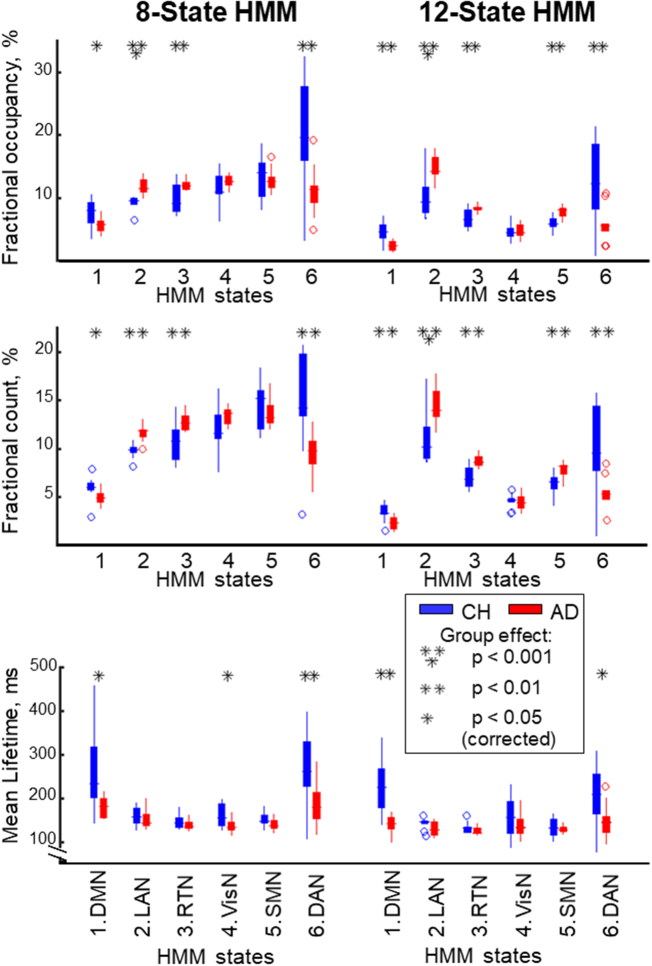
Group differences in temporal characteristics of the states inferred in the HMM with 8 states on the left and 12 states on the right. Boxplots illustrate value distributions (as described in Fig. 6) for fractional occupancy (top), fractional count (middle), and mean lifetime (bottom) for six salient states (labeled in the bottom), inferred in each model. Abbreviations are the same as in Fig. 2.